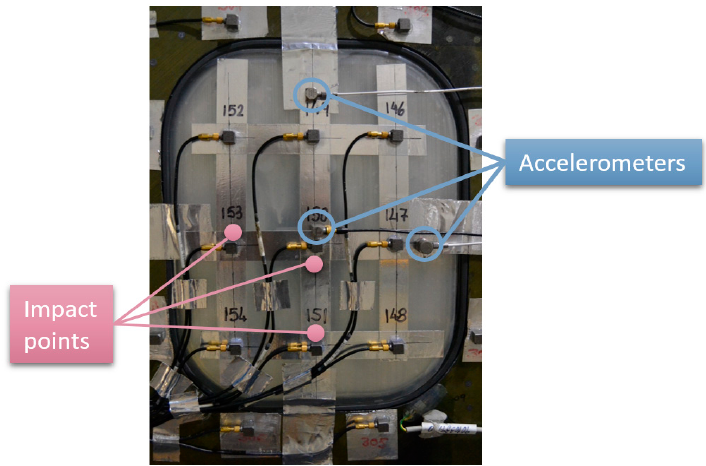
Figure 5. Set-up for impact hammer tests on the passenger window of the GRA front fuselage demonstrator (exterior view).